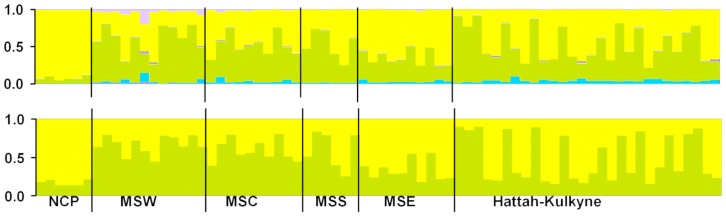
TESS boxplots for Kmax = 6 (top) and Kmax = 2 (bottom) based on 12 nuclear loci for 72 individuals.NCP = Ngarkat Conservation Park, MSW = Murray-Sunset (West), MSC = Murray-Sunset (Central), MSS = Murray-Sunset (South), MSE = Murray-Sunset (East).